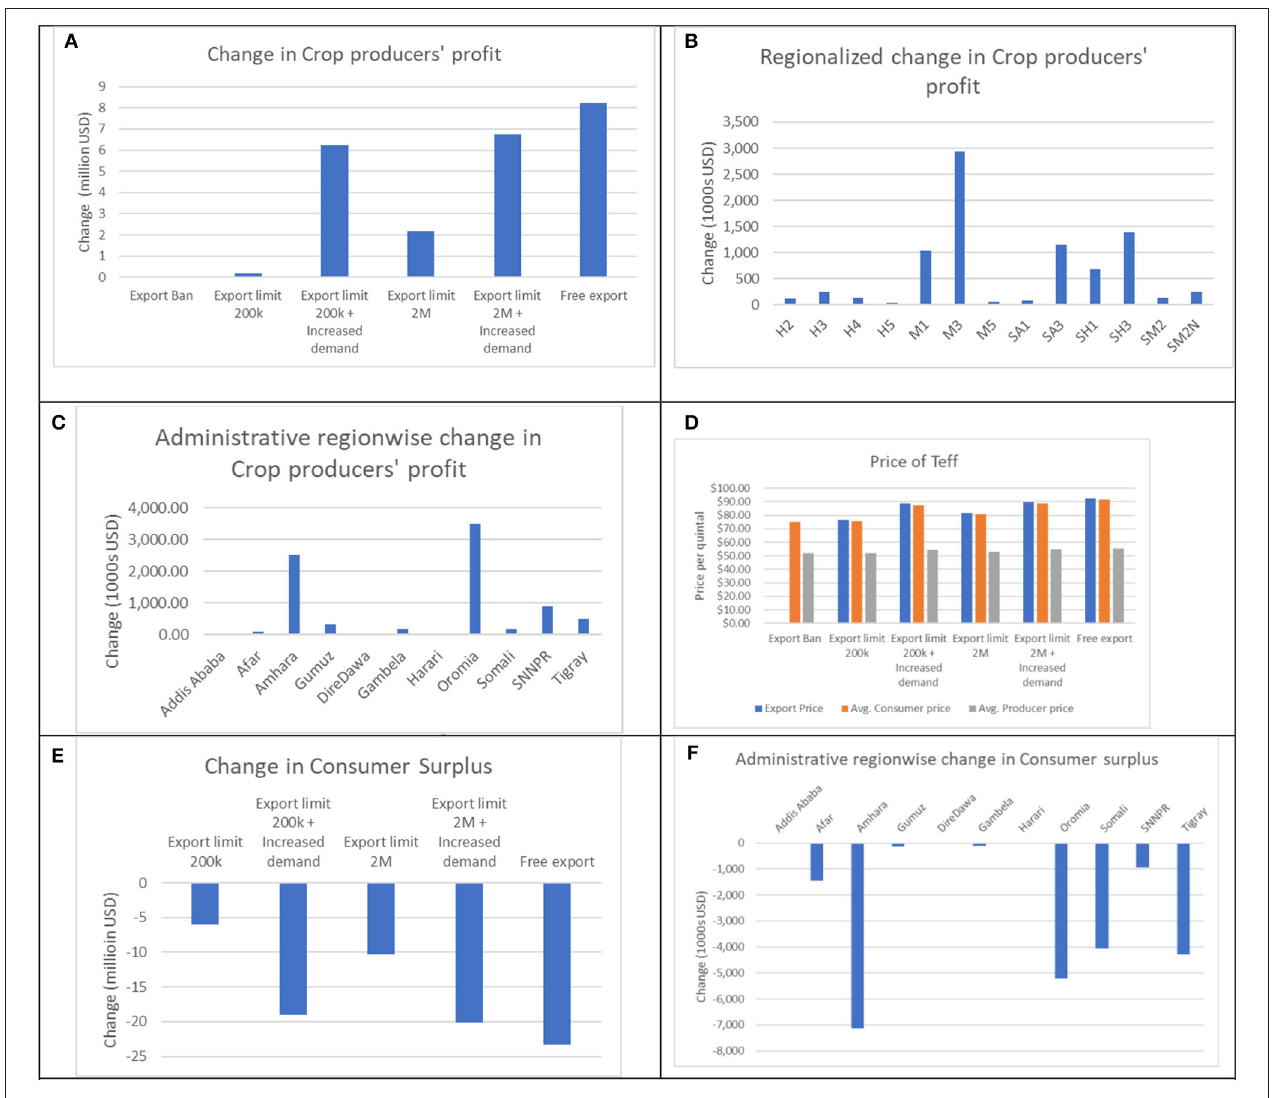
FIGURE 2 | Crop producers’ profits, consumer surplus and consumer prices under different scenarios. (A) Change in aggregated crop producers’ profit under different scenarios with reference to the teff export-ban scenario. (B) Regionalized change in aggregated crop producers’ profit under the free export scenario—adaptation zone wise. (C) Change in aggregated crop producers’ profit under the free export scenario—administrative region wise. (D) Changes in aggregated producer, consumer, and export price of teff under different scenarios. (E) Change in aggregated consumers’ surplus under different scenarios